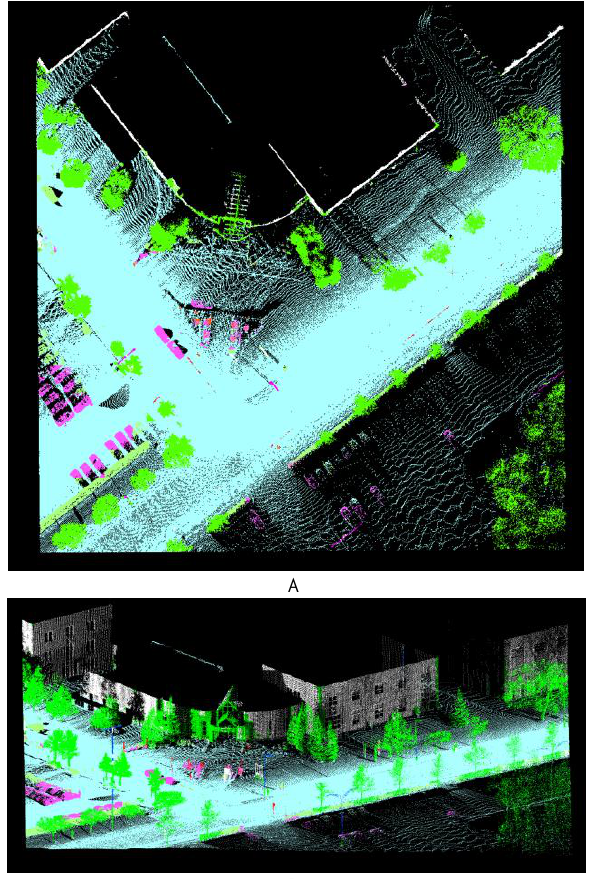
Figure 5. Classification result on testing point cloud (A) and its 3D view (B)